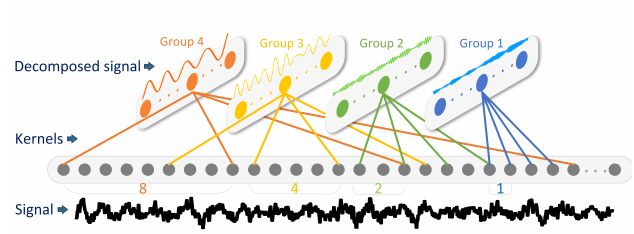
Figure 2. Signal decomposition of time convolutional layer. Black line at the bottom is the input signal. Four colors (orange, yellow, green and blue) at the upper and middle parts represent the four groups. Four capsules at the top represent the outputs of 4 groups. Four colors of straight lines at the middle part represent dilated convolutional kernels with a dilated rate of 8, 4, 2 and